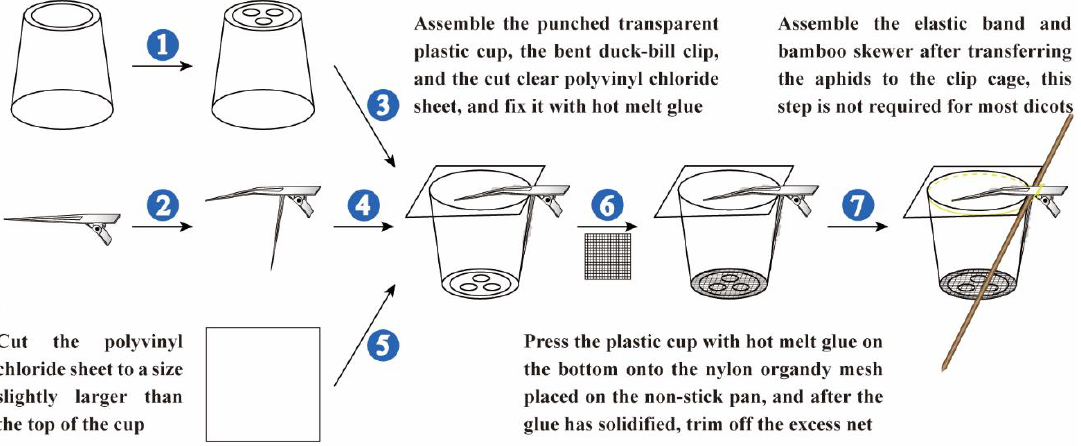
Figure 2. Demonstration of the steps to make a clip cage.